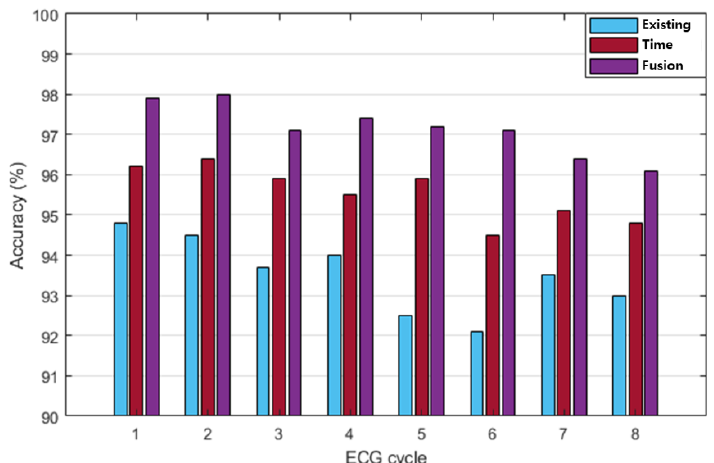
Figure 12. Comparative analysis of post-exercise ECG normalization recognition performance according to the number of ECG cycles (existing, time, and fusion normalization methods).